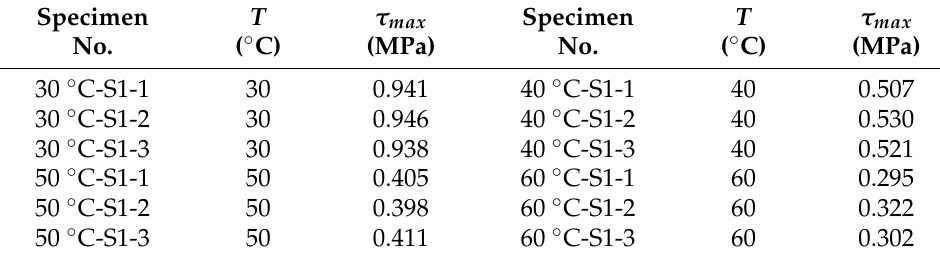
Table 3. The maximum shear stress of various specimens at different temperatures.